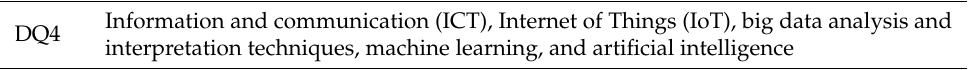
Data Extractions